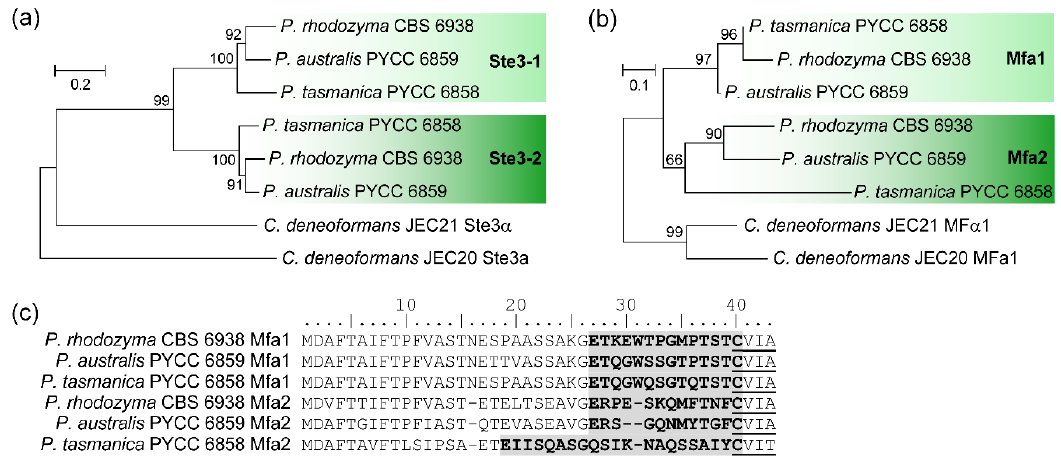
Figure 5. Trans-specific polymorphism of pheromone receptor genes in the genus Phaffia . Phylogeny of pheromone receptors ( a ) and pheromone precursor proteins ( b ) from all Phaffia species, and alignment of pheromone precursor proteins ( c ). Predicted mature pheromones are highlighted in grey with bold font and the C-terminal motif for posttranslational processing is underlined.